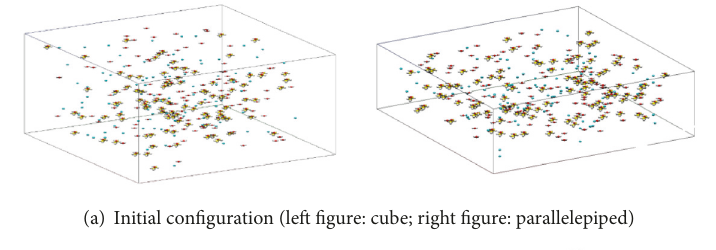
(a) Initial configuration (left figure: cube; right figure: parallelepiped)